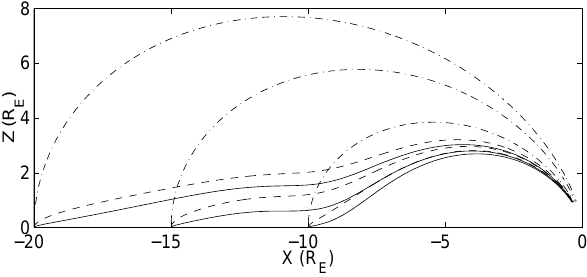
Fig. 5. Schematic showing the dipole magnetic field lines (dot- dashed) compared to our stretched magnetotail for two different current sheet